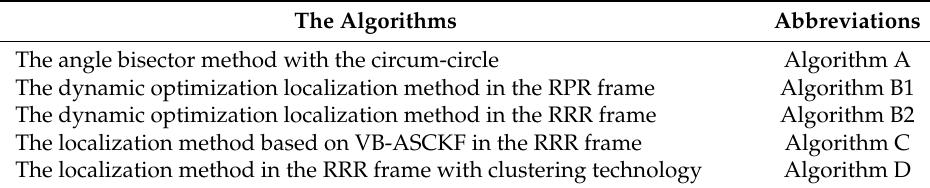
Table 2. The abbreviations of the algorithms used in this section.